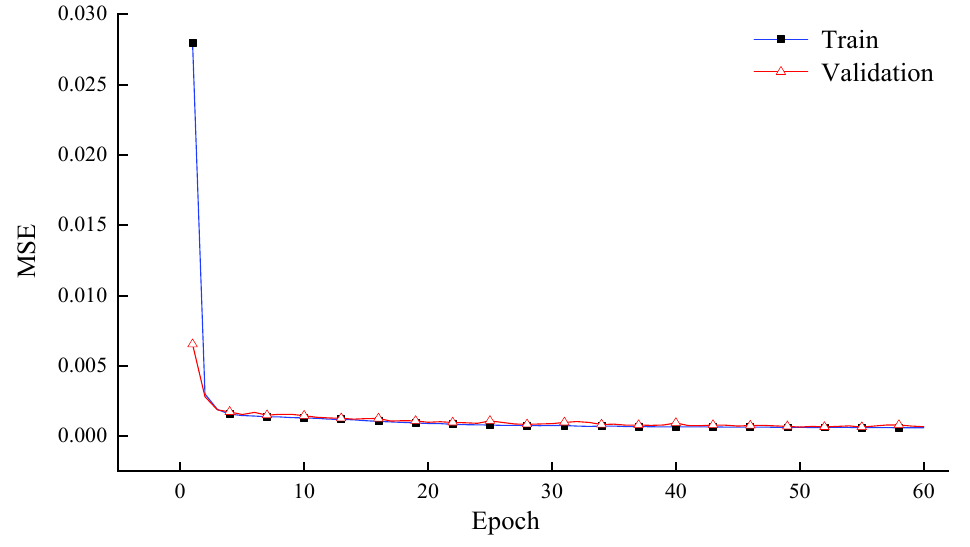
Figure 3. Training performance of the LSTM network in terms of MSE of the training and validation partitions.